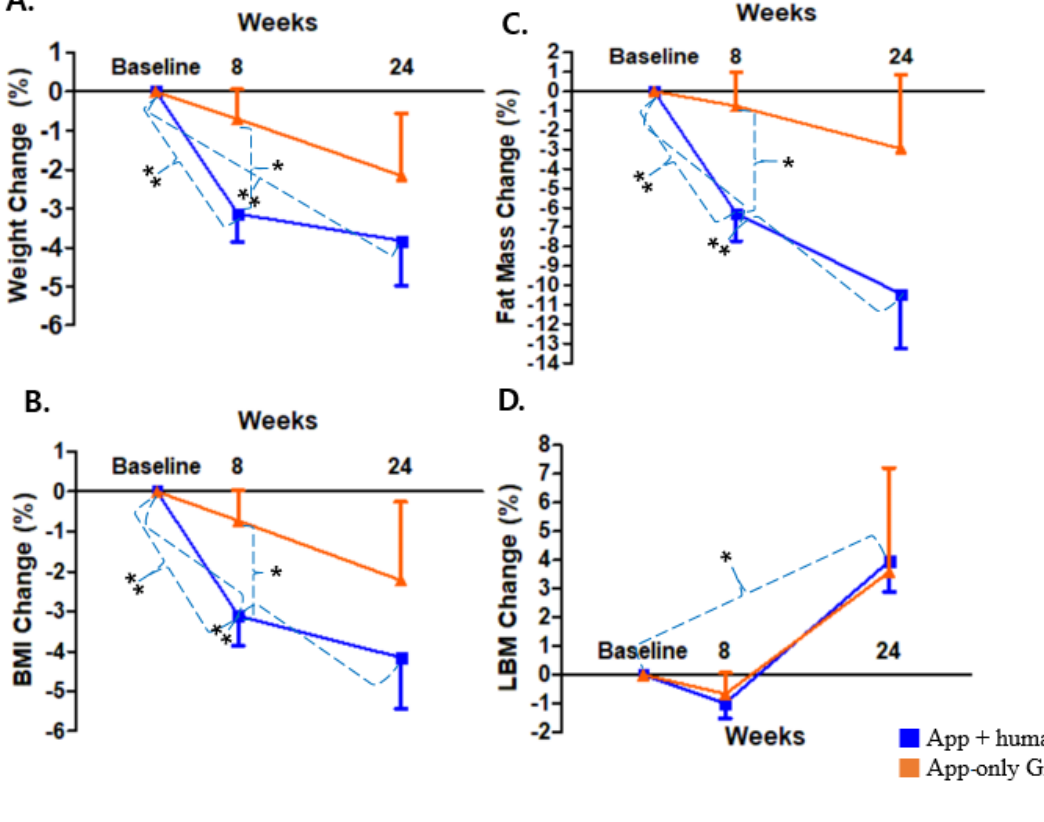
Figure 4. Patterns of changes in mean body weight (A), BMI (B), body fat mass (C), and lean body mass (LBM) (D). CBT: cognitive behavioral therapy. * P <.05; ** P